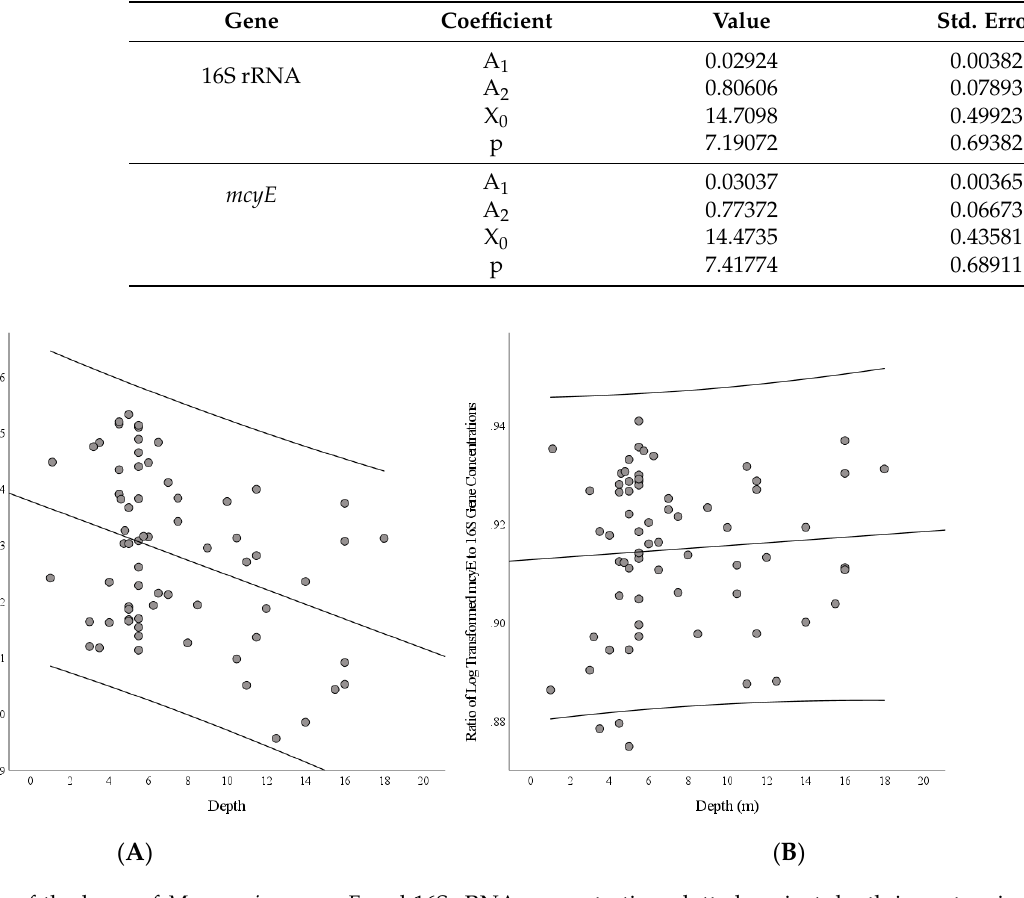
Table 3. Coefficients for GLM equation predicting ratio of near-surface/near-bottom gene concentra- tions with depth.